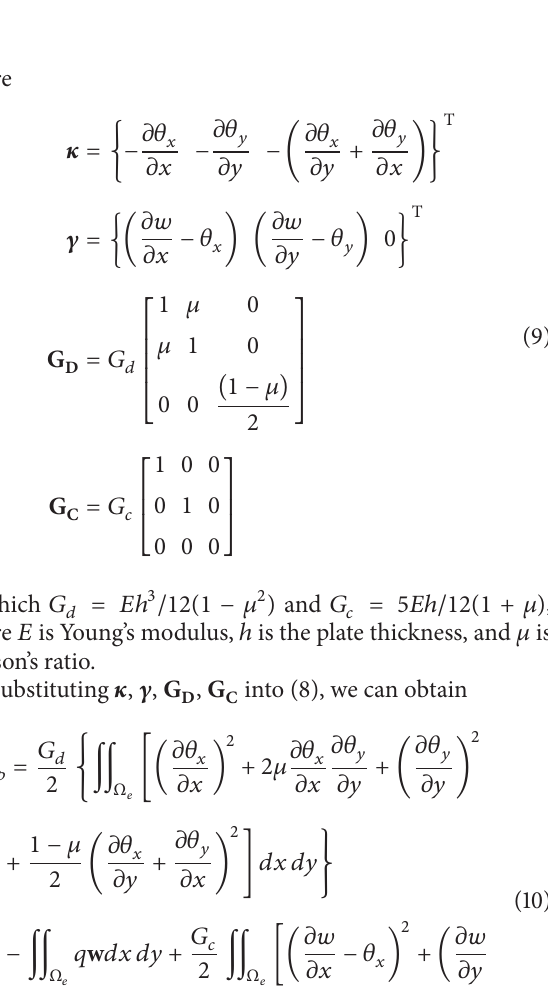
Figure 5: Rectangle elemental solving domain in Mindlin